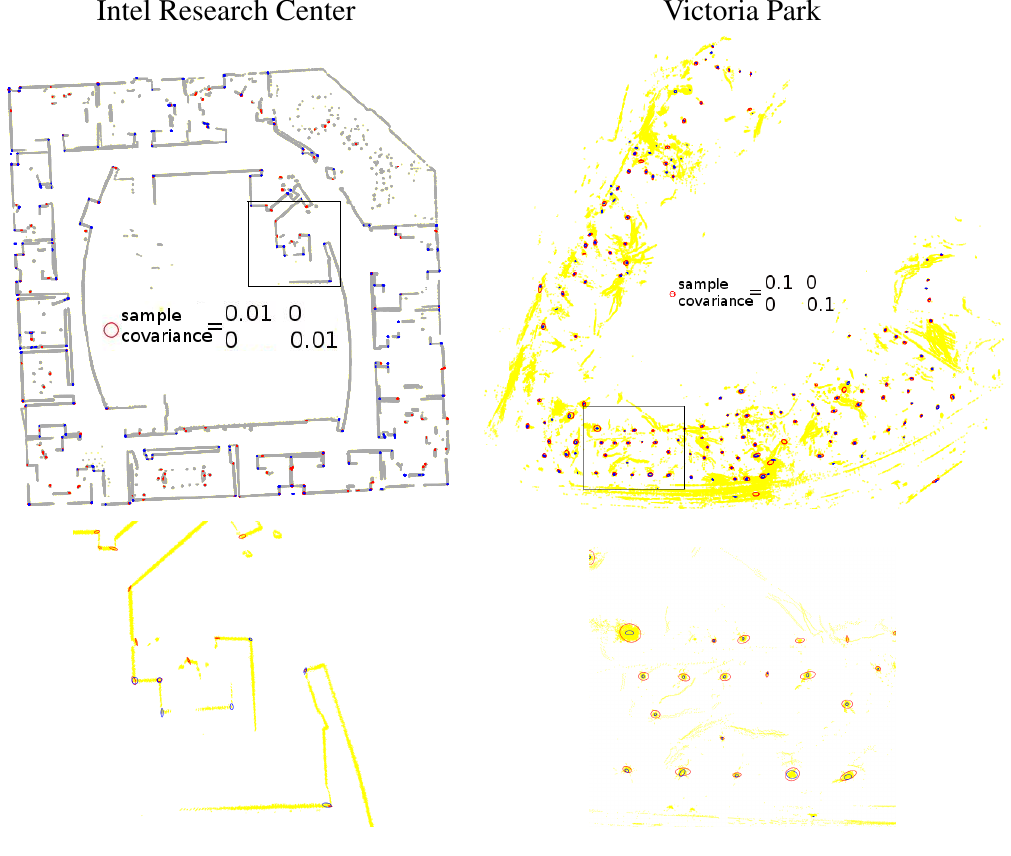
Figure 11. Uncertainty. Top: the sample variance of detected features is shown; the size of each ellipse corresponds to 3 σ confidence. Bottom: Larger views of the framed parts of the top